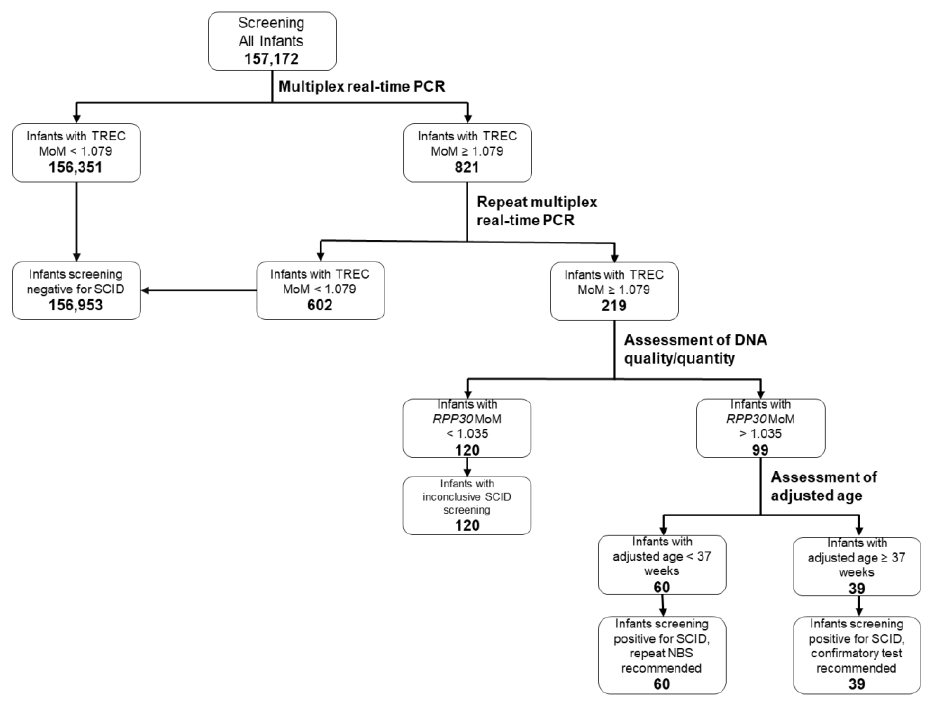
Figure 1. Wisconsin SCID newborn screening algorithm. Of the 157,172 infants screened for SCID between September 2018 and March 2021, 156,953 had a TREC MoM value of <1.079 on either the initial assay or when subsequently re-tested in duplicate. This resulted in 99.86% of infants screening negative for SCID. Another 120 infants had inconclusive screens, with a TREC MoM ≥ 1.079 and a RPP30 MoM >1.035, and thus repeat NBS was recommended for these infants. Finally, 99 infants screened positive for SCID. Of these, 60 had adjusted ages of <37 weeks and had repeat NBS recommended. The remaining 39 infants, whose adjusted ages were ≥ 37 weeks, were referred for confirmatory testing based on the results of their initial NBS for SCID (Figure